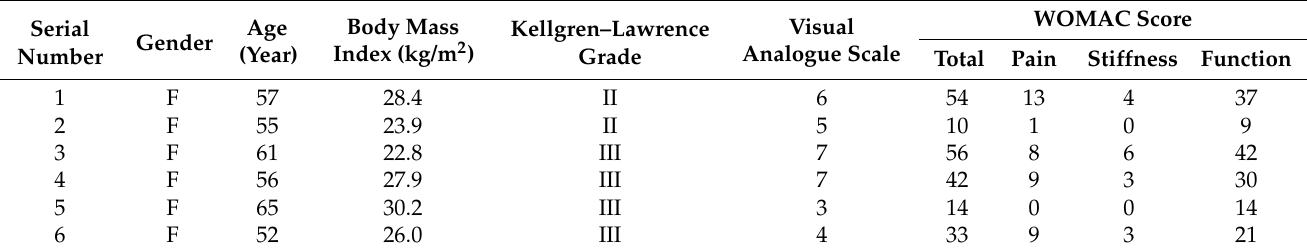
Table 1. Data of six patients at profiling stage.